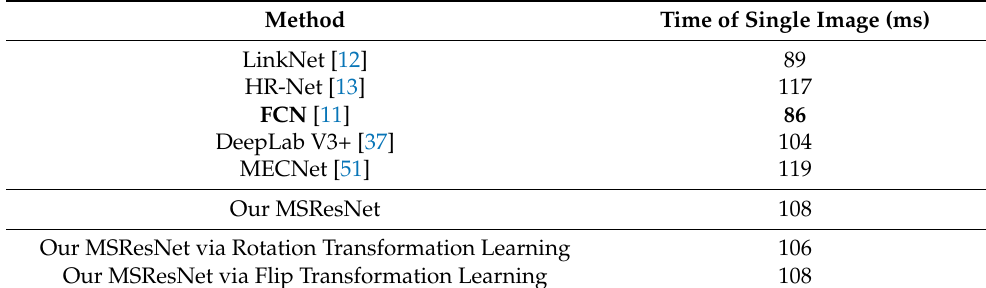
Table 4. The running times for detecting water bodies from one single image by different methods on the 2020 Gaofen Challenge water-body segmentation dataset.